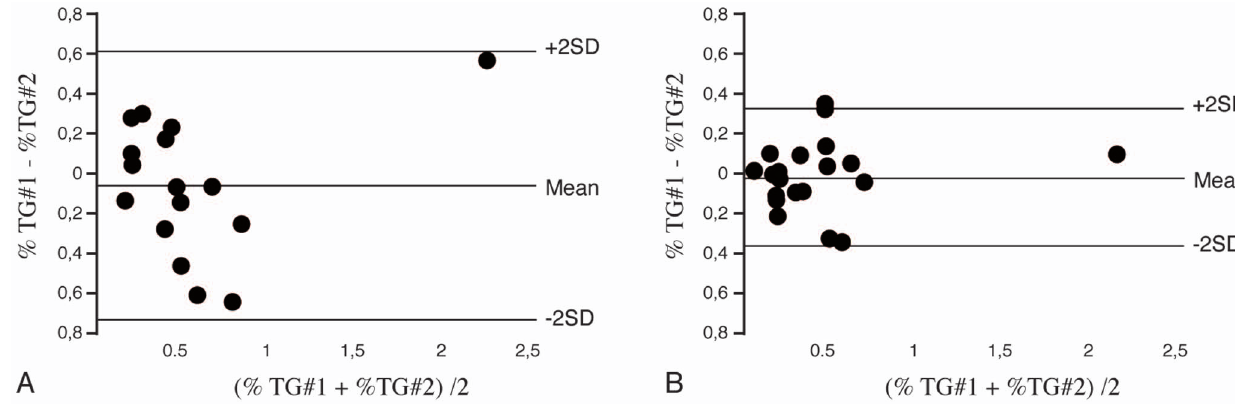
Figure 4. Reproducibility plots of renal triglyceride content. Bland-Altman plots of renal cortical triglyceride (TG) content calculated from spectra without (n=16, A) the use of the respiratory navigator, and with (n=20, B) the use of the respiratory navigator showing narrower limits of agreement/improved reproducibility.